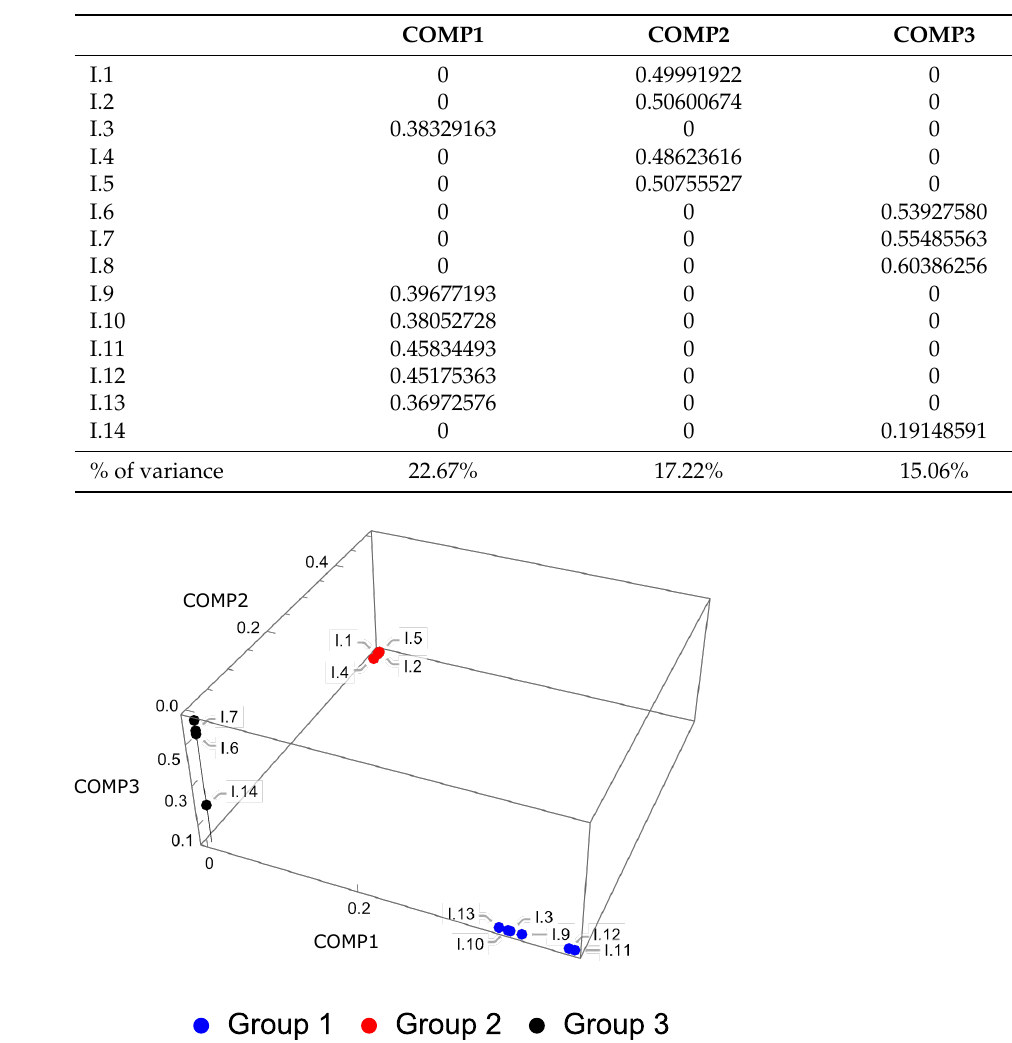
Figure 5. WhatsApp items space on three disjoint components for Indian